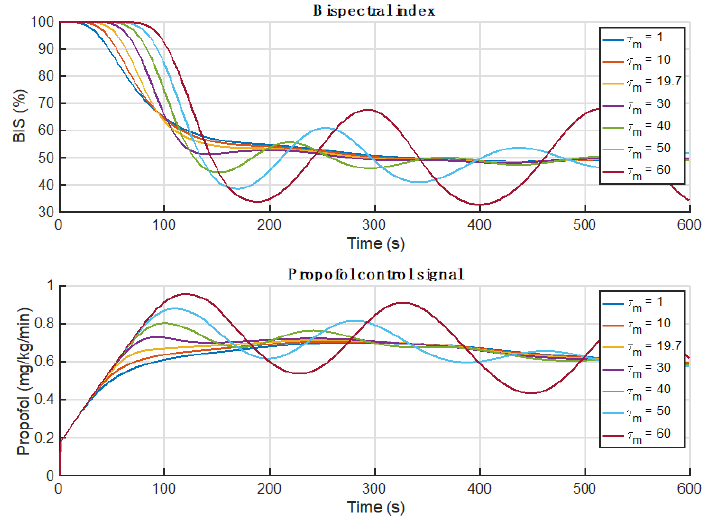
Figure 19. Computed BIS and Propofol values in the case of dead-time variations in BIS measure- ment.